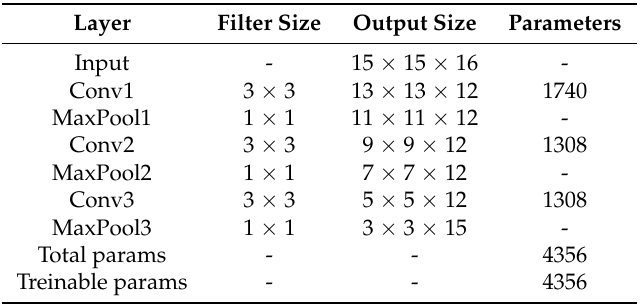
Table 5. Architecture details of the CSVM